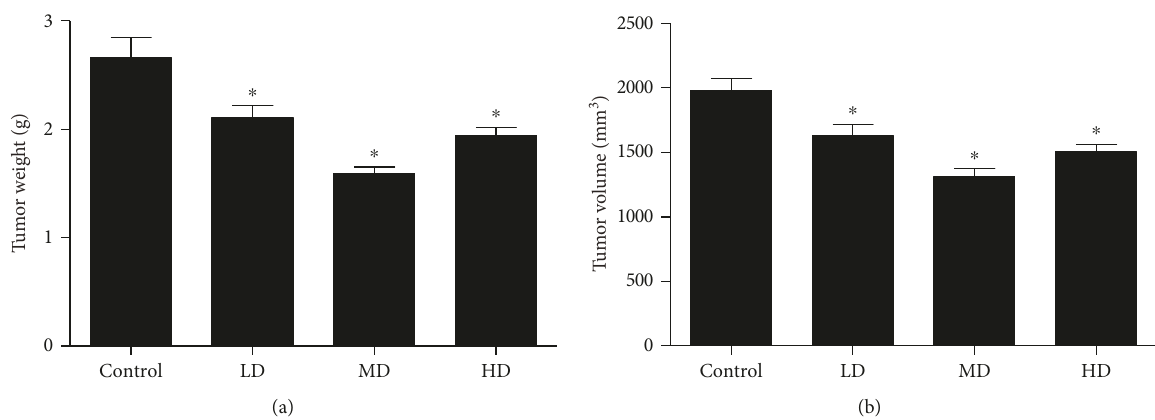
Figure 1: (a, b) The tumor weight and tumor volume of mice in di ff erent groups. Data were presented as mean ± SD . ∗ p < 0 05 , compared with the control